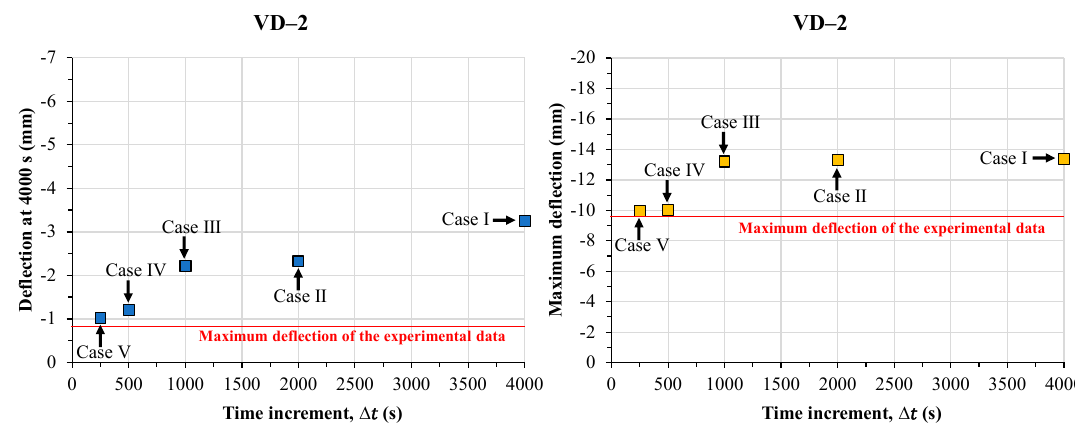
Figure 24. Deflection at 4000 s and maximum deflection versus time increments ( ∆𝑡 ) at VD-2.